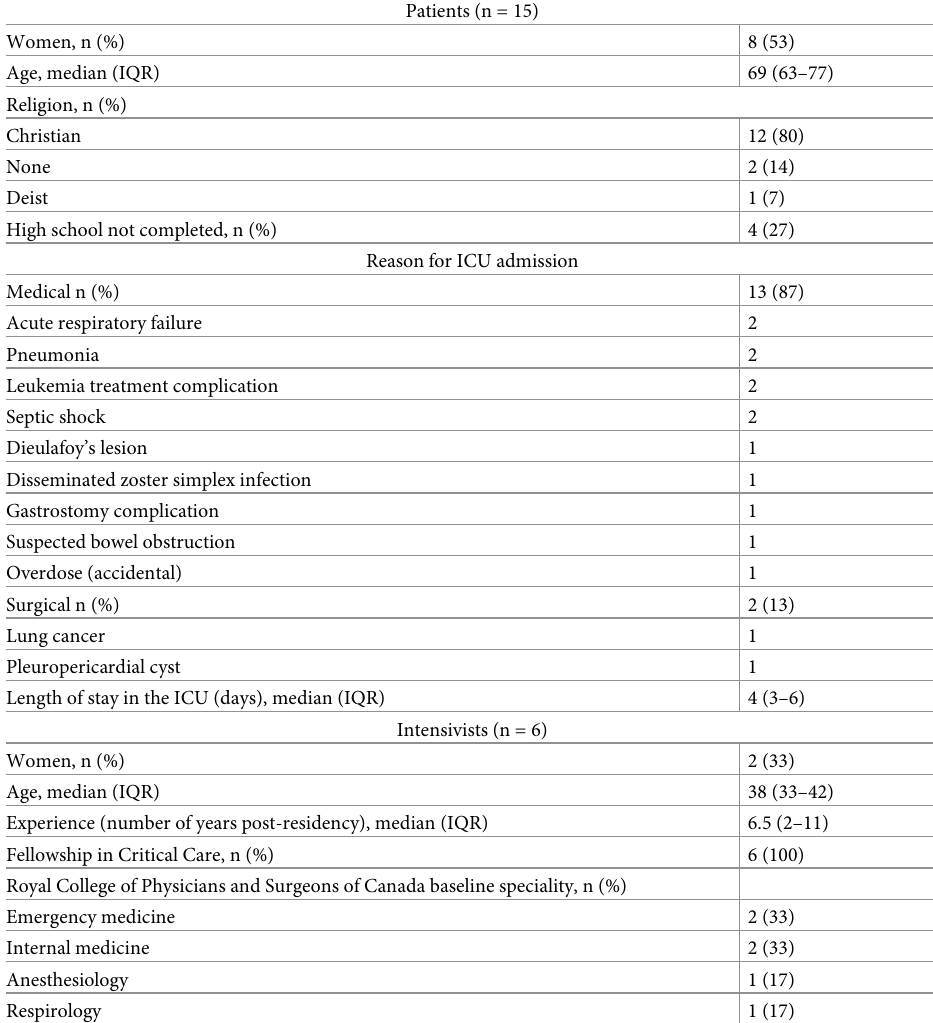
Table 3. Description of the participating patients and